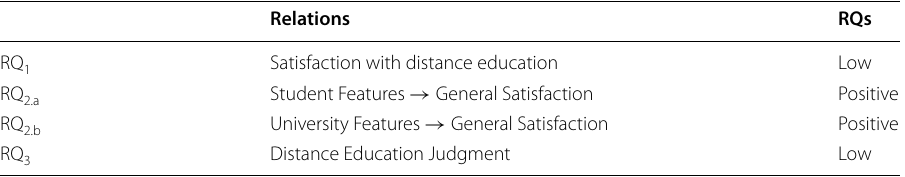
Table 8 Summary of test